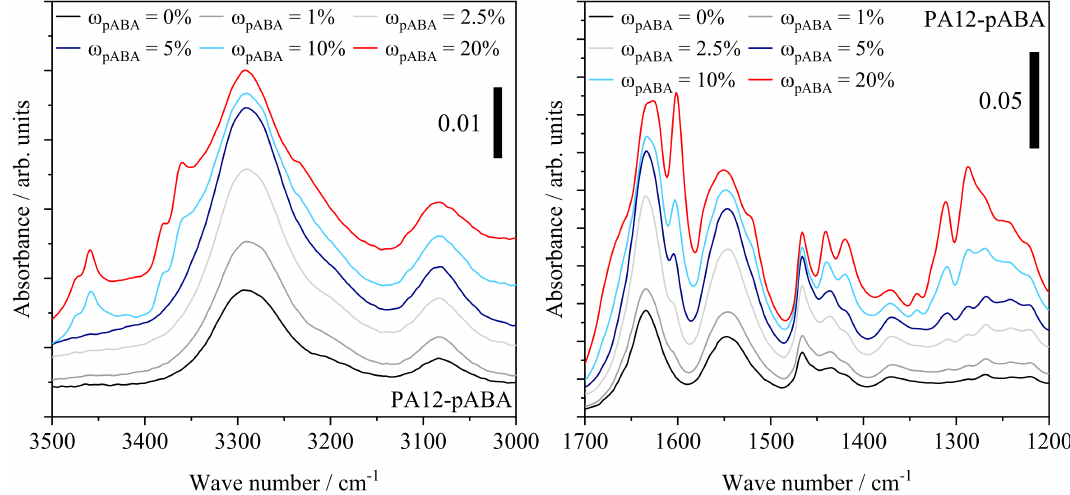
Figure 13. Infrared spectroscopic measurements of manufactured tensile specimens in dependence of the underlying fraction of p-aminobenzoic acid; adapted ordinate